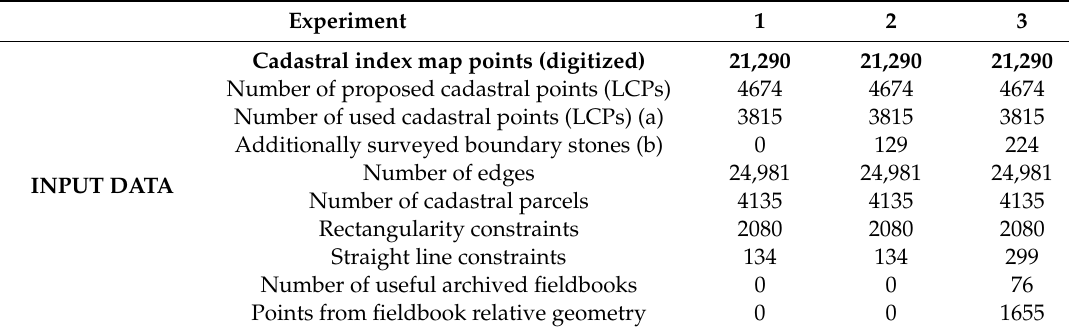
Table 2. Input data